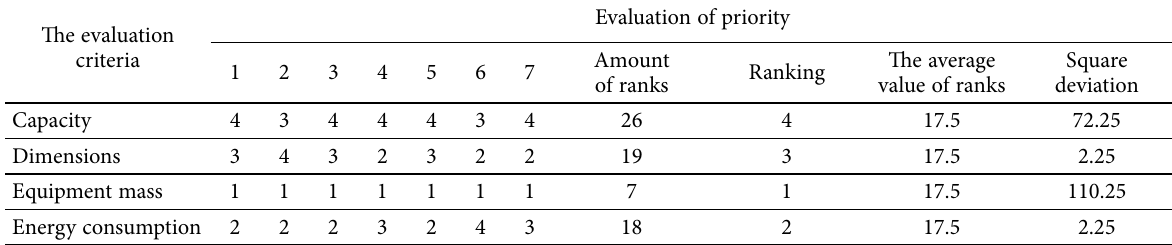
Table 3. Ballast water treatment criteria